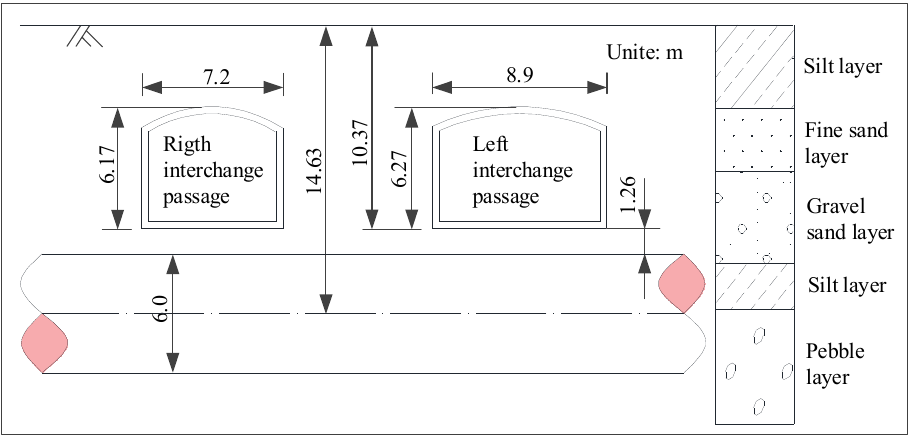
Figure 7. Sectional view of interchange passages and Metro Line 10.